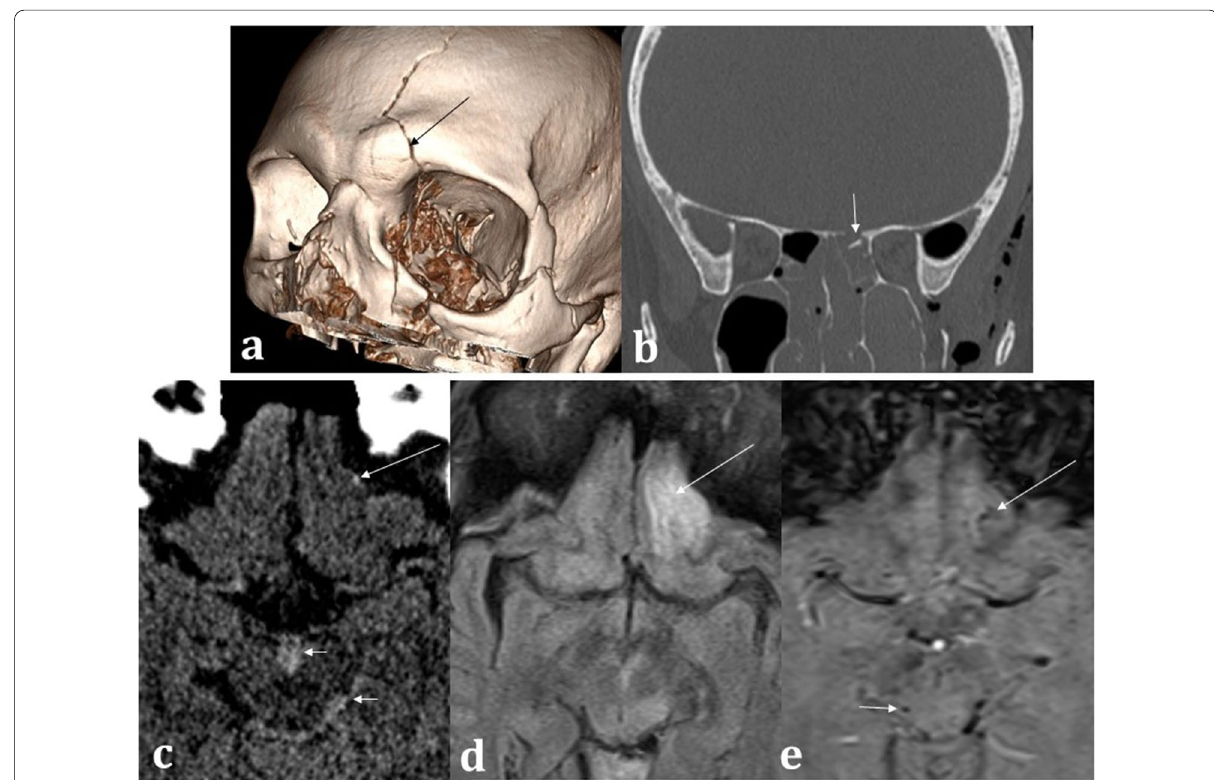
Fig. 14 Trauma. 67-year-old male hit by a train. 3D CT reconstruction ( a ) demonstrates left-sided Le Fort III fracture complex and a calvarial fracture involving the frontal bone (arrowed). Coronal bone window CT ( b ) demonstrates an anterior cranial fossa fracture (arrowed) placing the patient at risk of inferior frontal lobe injury. Axial soft tissue window CT ( c ) confirms subtle punctate haemorrhage at the inferior frontal lobe (long arrow) as well as interpeduncular and ambient cistern subarachnoid haemorrhage (short arrows). The MRI axial FLAIR sequence ( d ) demonstrates a corresponding area of abnormal left inferior frontal lobe signal involving the olfactory sulcus (arrowed) with microhaemorrhages on the SWI ( e ) sequence (long arrow). Additional microhaemorrhages within the midbrain are consistent with grade III diffuse axonal injury (short arrows), and the aforementioned cisternal subarachnoid blood is also seen. The patient unfortunately passed away from related traumatic